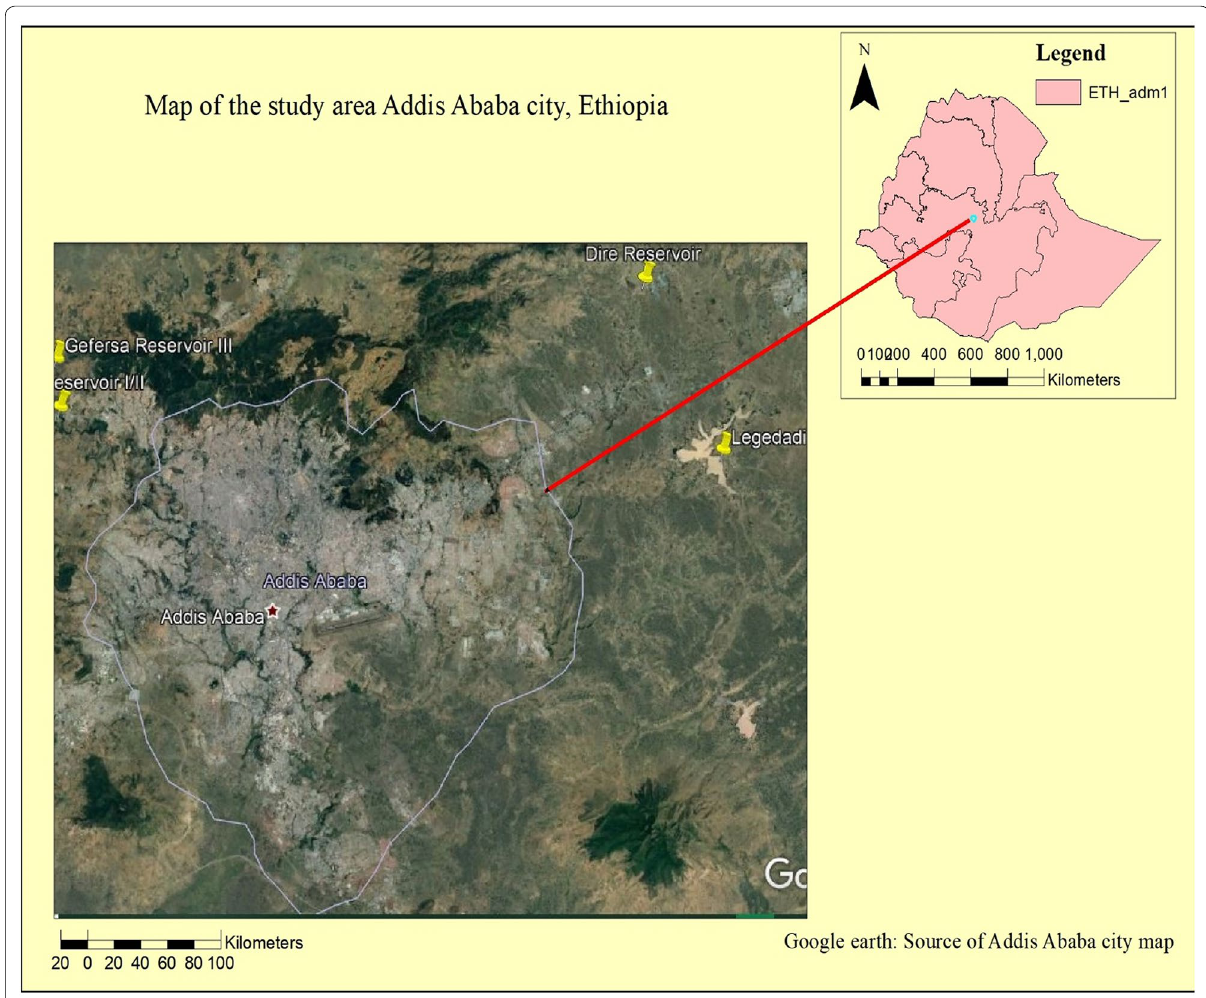
Fig. 1 Map of the study area Addis Ababa city, Ethiopia